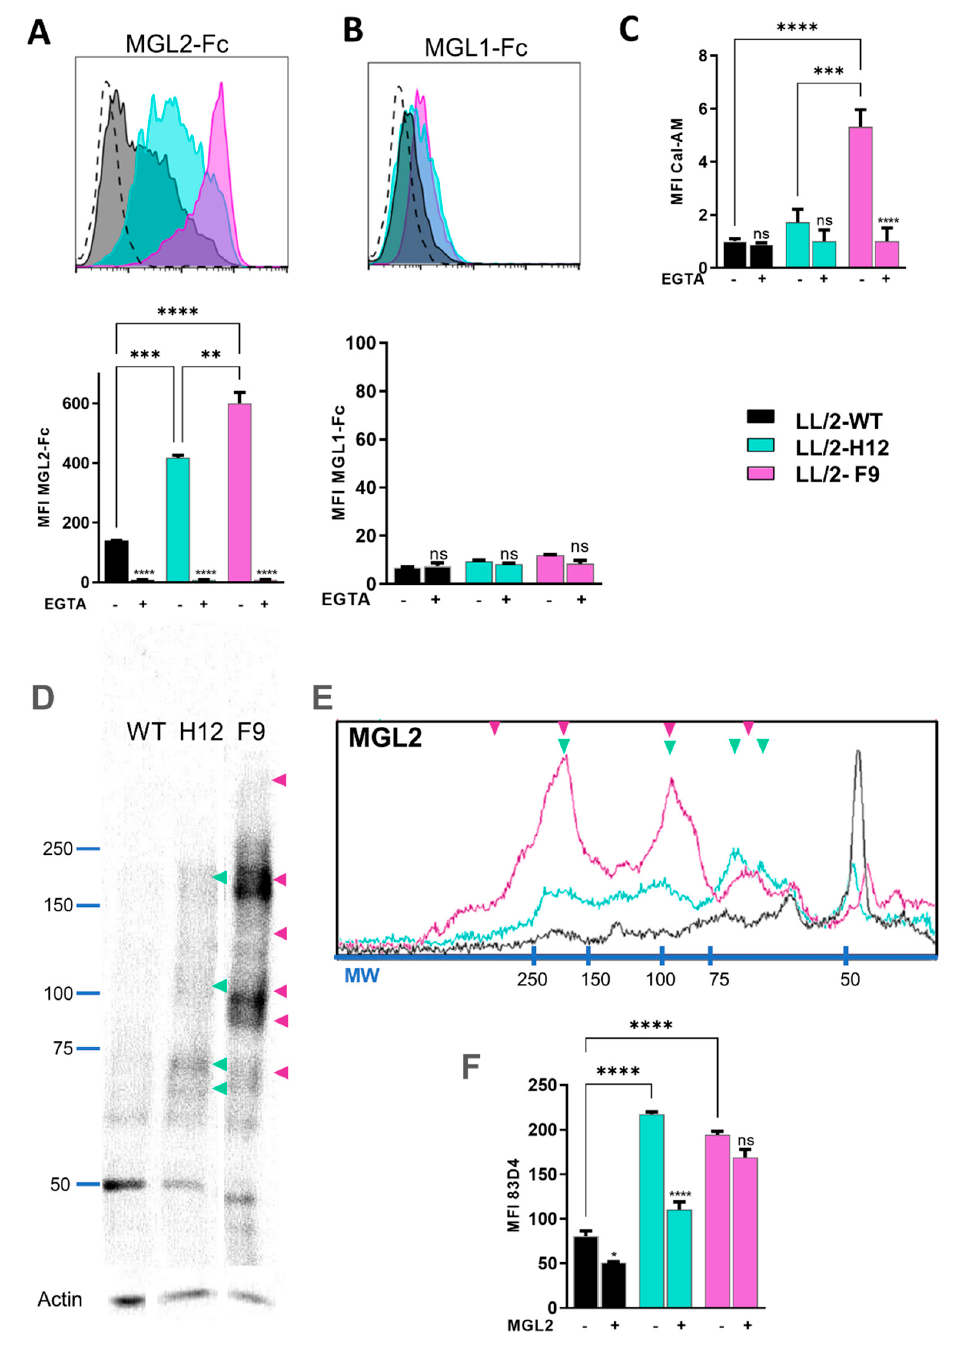
Figure 4. MGL2 differently interacts with LL/2-Tn + cell variants. ( A,B ) Recognition of LL/2 tumor cells with soluble MGL2-Fc ( A ) or MGL1-Fc ( B ) analyzed by flow cytometry. Bottom, Median fluorescence intensity (MFI), in the presence or absence of EGTA. ( C ) Binding of MGL2 + CHO cells to the LL/2 cell variants by solid phase assay. ( D ) Lectin blot analysis of whole cell lysates, membranes using MGL2-Fc. Green and violet arrows represent components recognized in LL/2-Tn + -H12 and LL/2-Tn + -F9 cells, respectively. ( E ) Densitometry of MGL2-Fc recognition of cell lysates by lectin blotting. ( F ) Anti-Tn 83D4 mAb staining of LL/2 cell lines, with or without pre-incubation with MGL2-Fc. Asterisks represent significant differences (* p < 0.05, ** p < 0.01, *** p < 0.001, **** p < 0.00001); ns: non-significant.